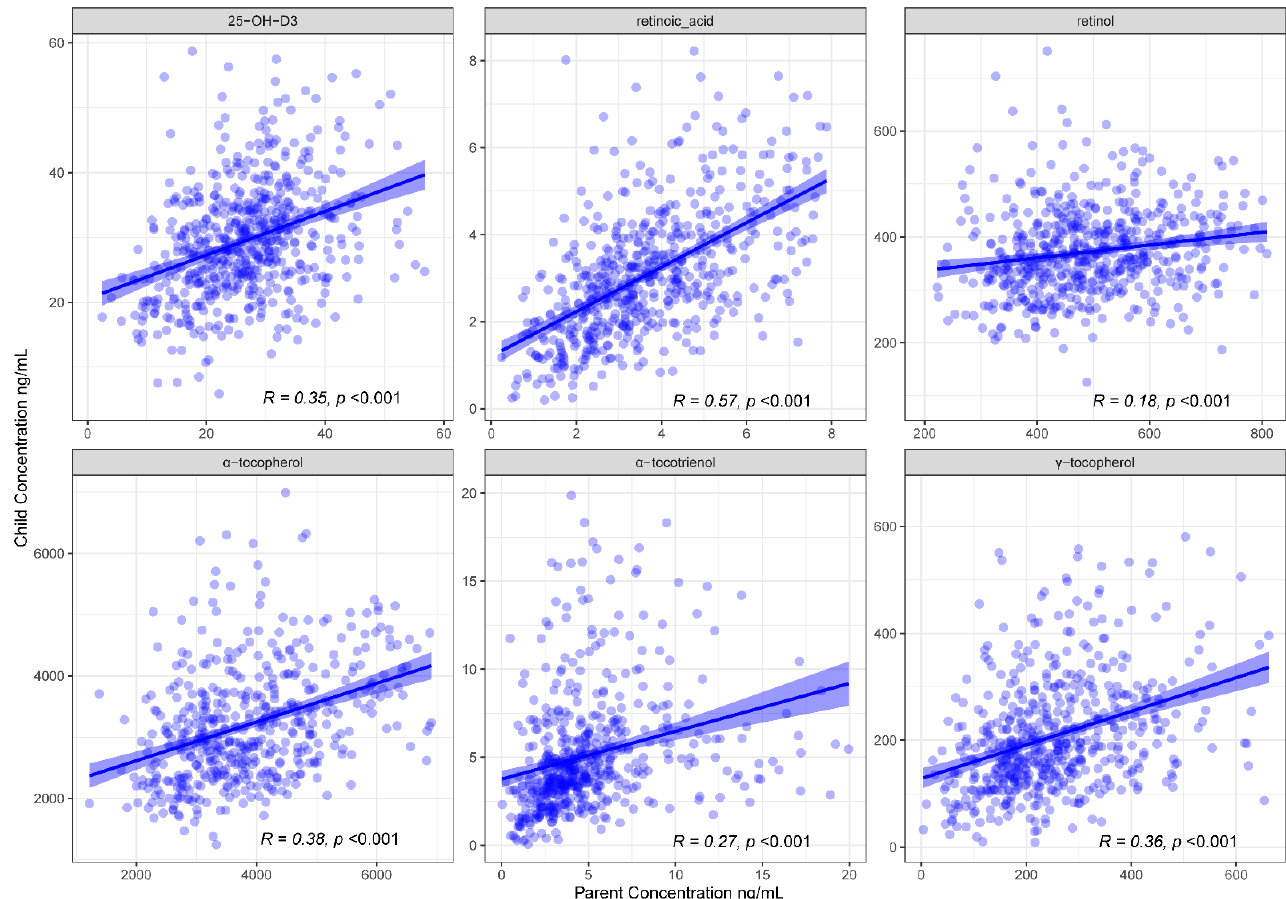
Figure 1. Scatter plots of parent-child FSV concentrations showing parent-child concordance. Linear models were fitted (R and p values as shown) with a 95% confidence interval.